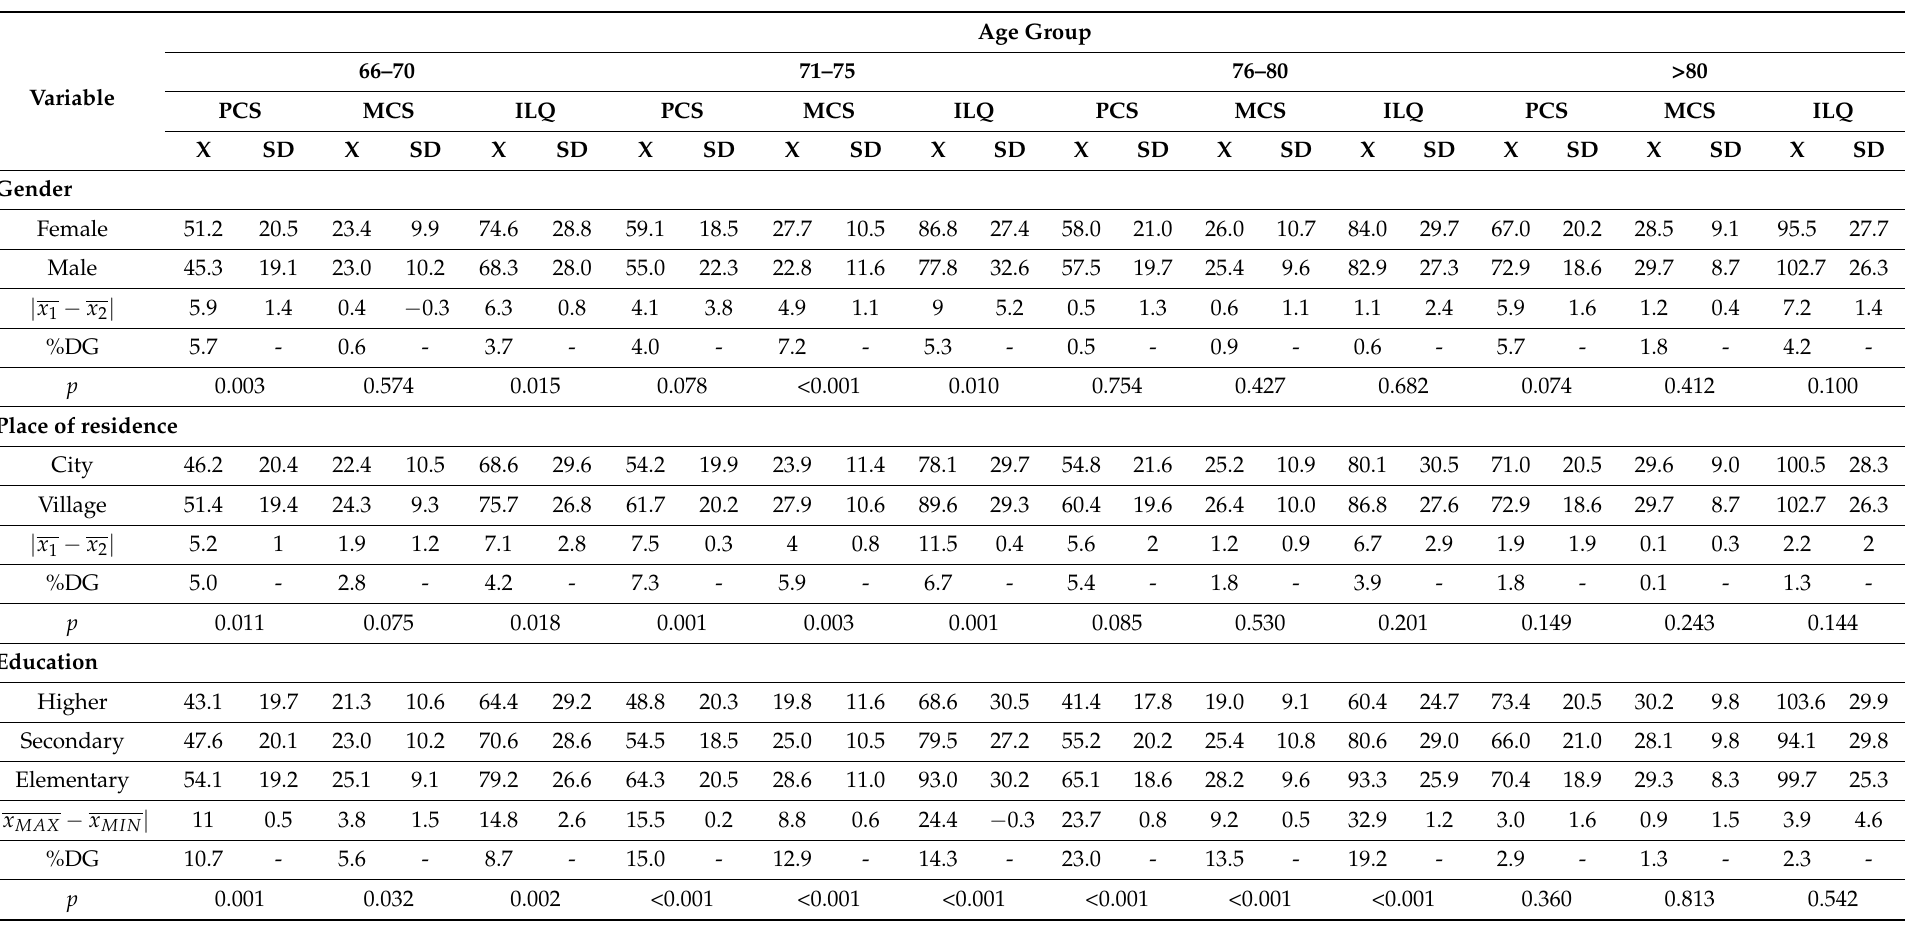
Table 4. Average level of the HRQoL in individual spheres, considering the intergroup averages (point values) and the differences between